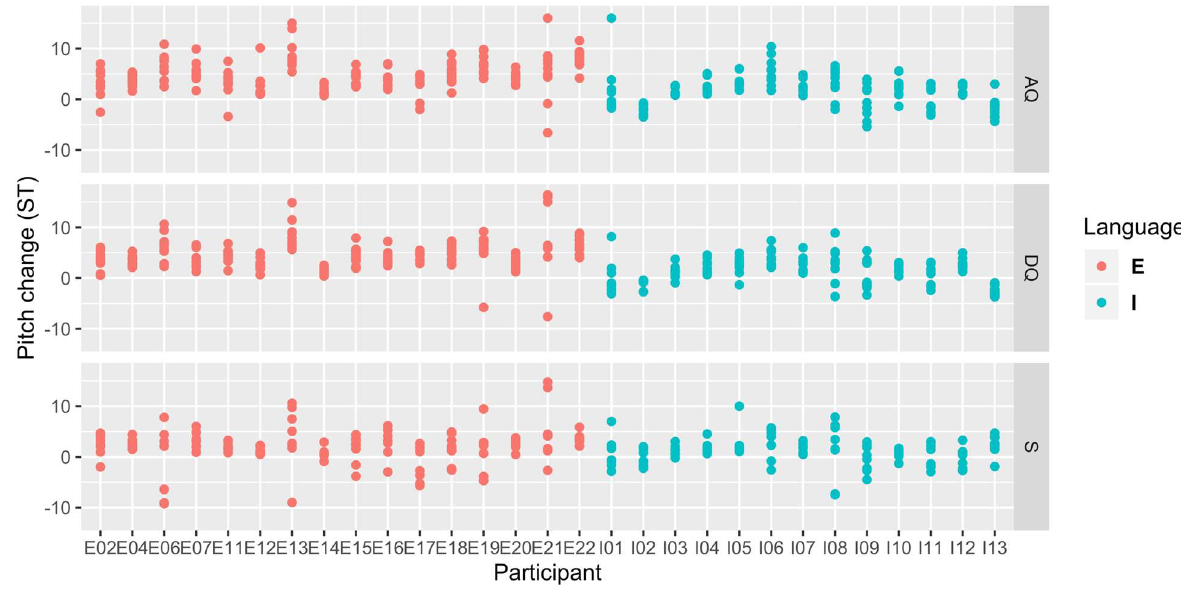
Figure 8. Pitch change in the first pitch accent (SI task) in each sentence type by participant.